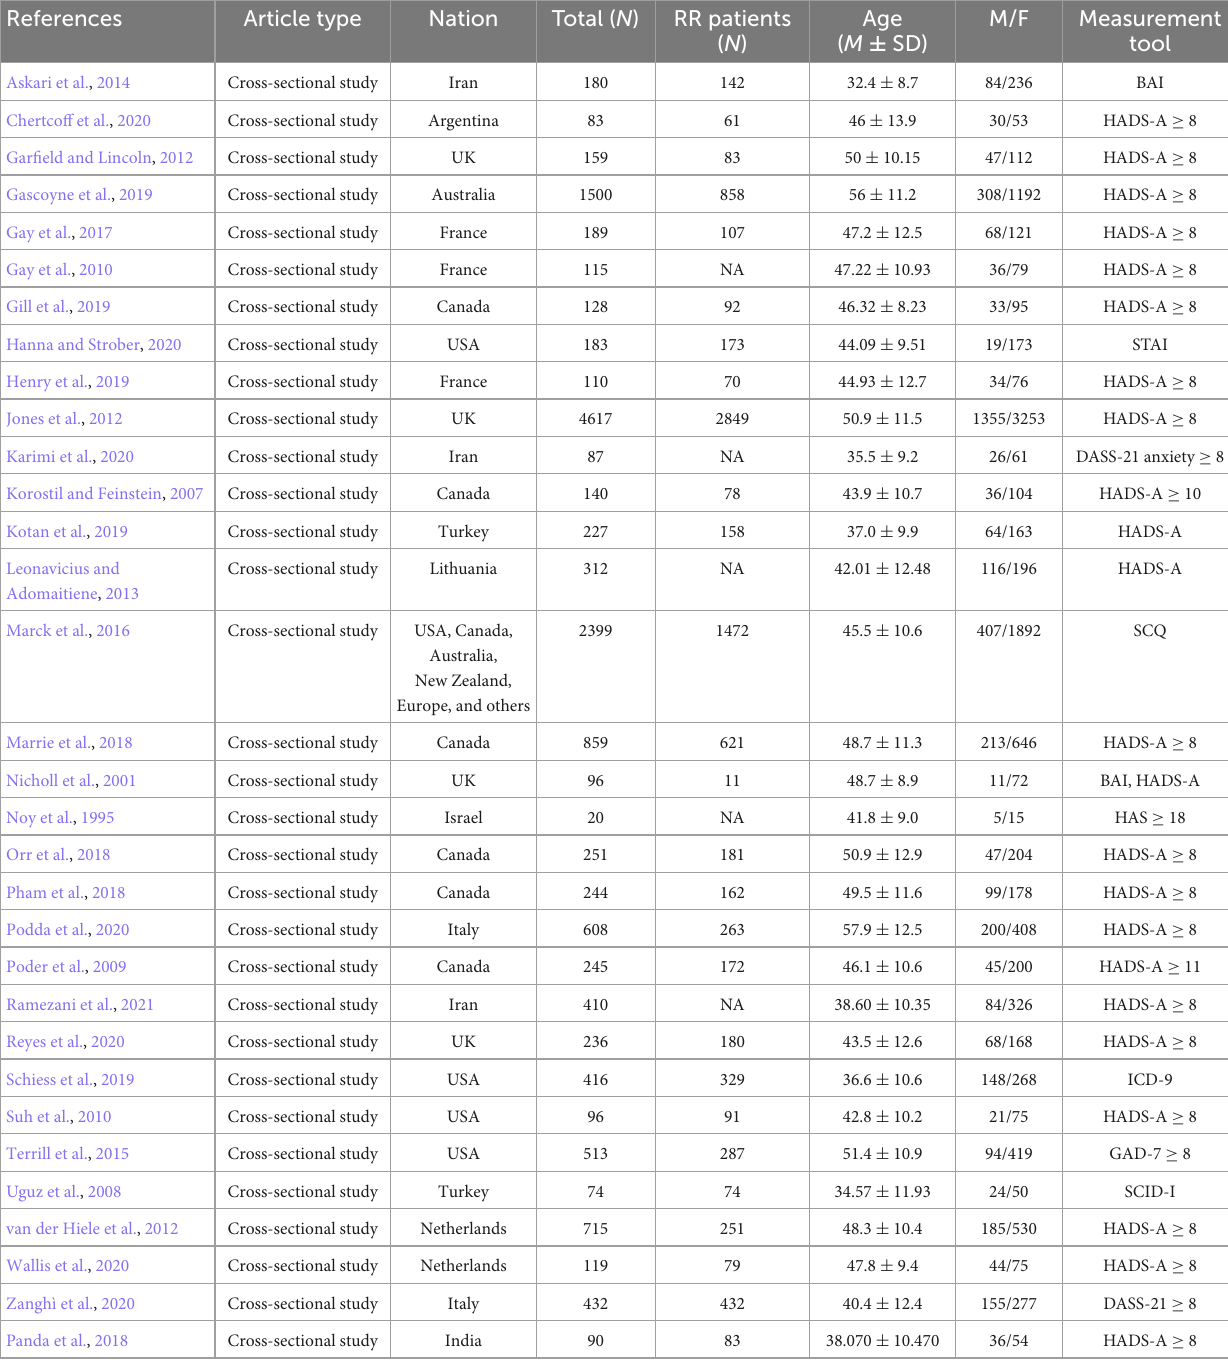
TABLE 1 Characteristics of included